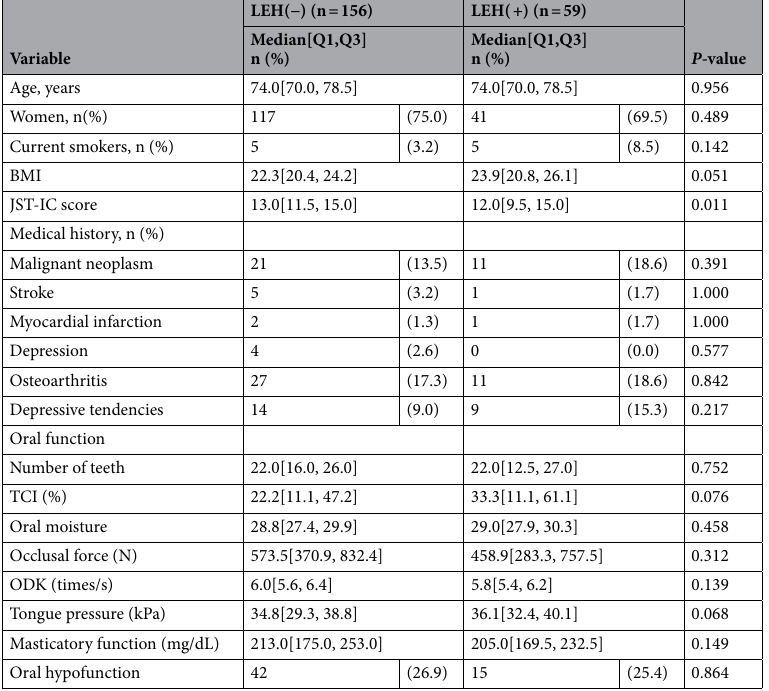
Table 2. Comparison between the two groups with and without lack of exercise habits. Categorical variables are shown as numbers (percentages) and were analyzed by performing either the chi-square test or Fisher’s exact test. Continuous variables are expressed as median [Q1, Q3], and were analyzed by performing the Mann–Whitney U test. P -values < 0.05 were considered statistically significant. Abbreviations: BMI, body mass index; JST-IC, Japan Science and Technology Agency Index of Competence; LEH, Lack of exercise habits; ODK, oral diadochokinesis; Q1, first quartile; Q3, third quartile; TCI, tongue coating